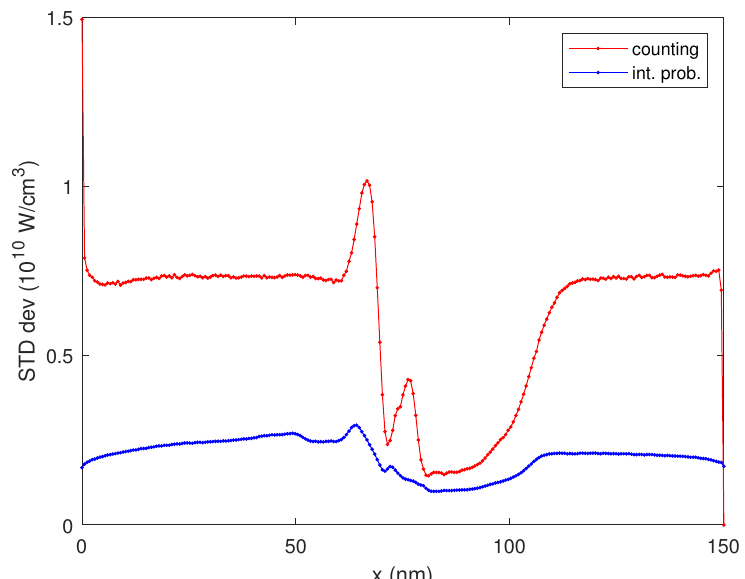
Figure 3. The standard deviation of the counting estimator (30) and the integrated probability estimator (32) versus position, for V b = 0.8 V.